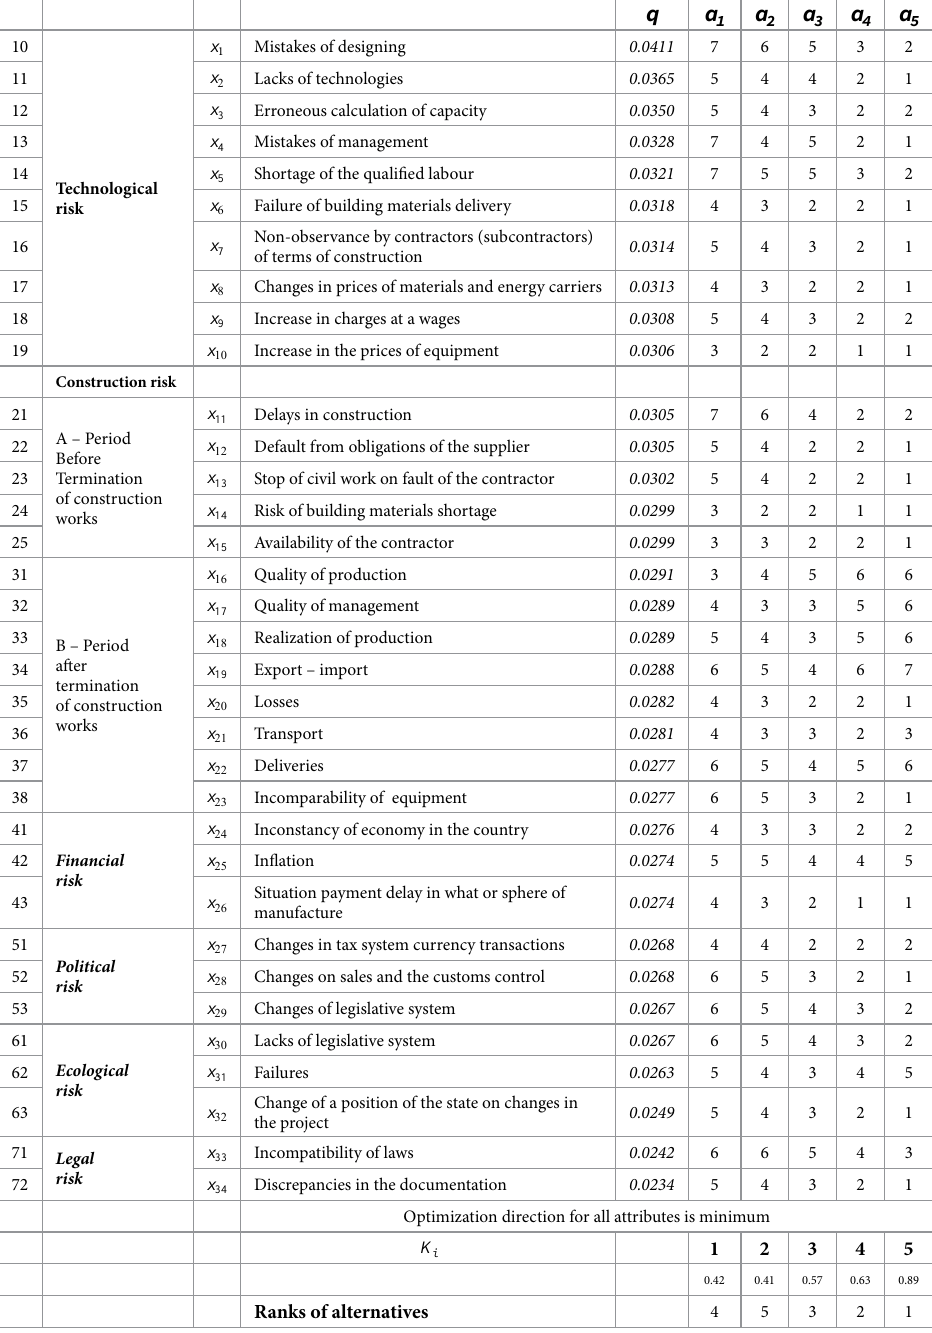
Table 1. The result table of experts interrogation – a matrix of